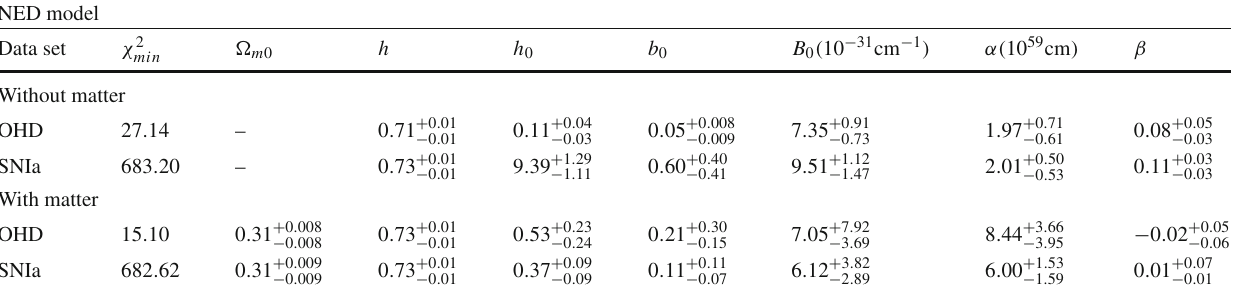
Table 1 Mean values for the NED parameters ( (cid:19) m 0 , h , α , and B 0 ) derived from OHD and SNIa data (JLA sample). When the SNIa data are used, we estimate M 1